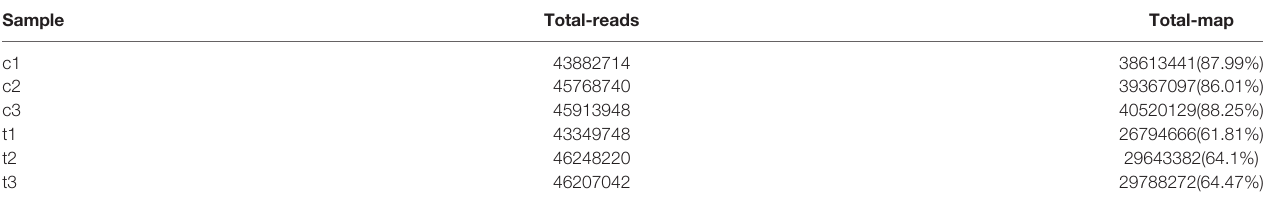
TABLE 4 | Transcriptome samples and reference genome comparison